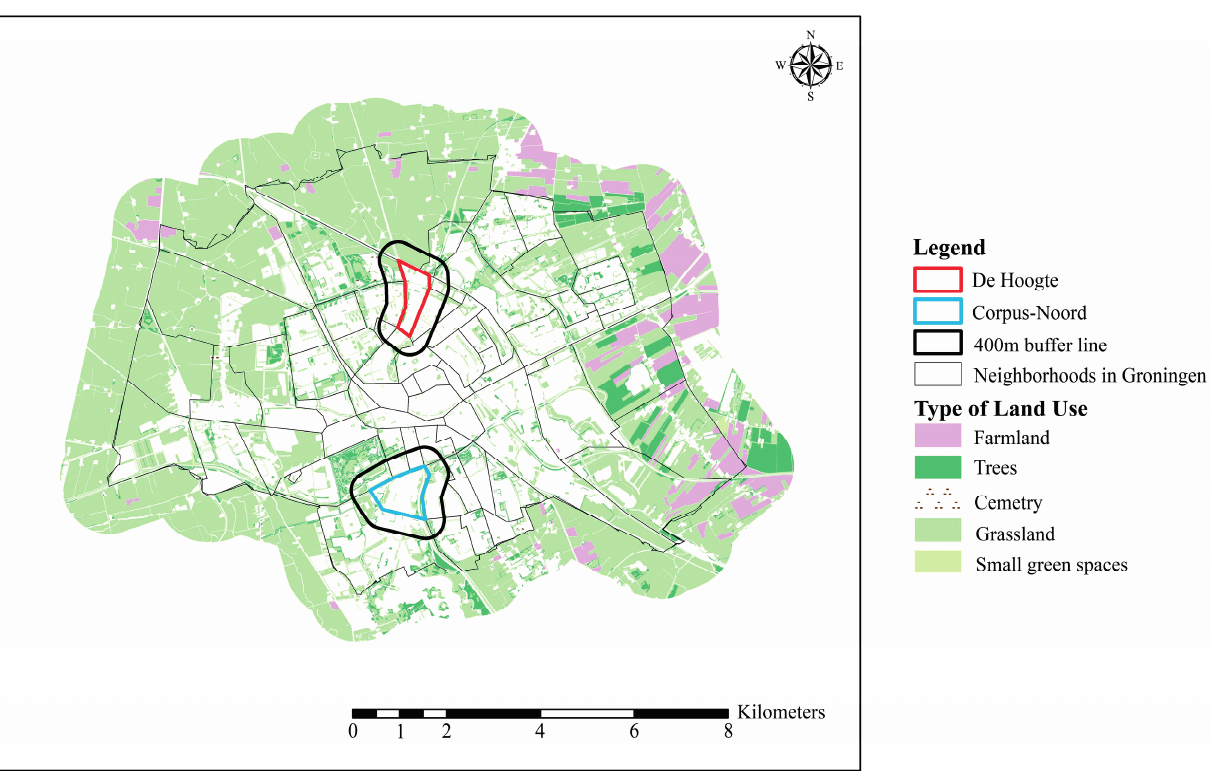
Figure 1. The neighborhoods of De Hoogte (north); and Corpus-Noord